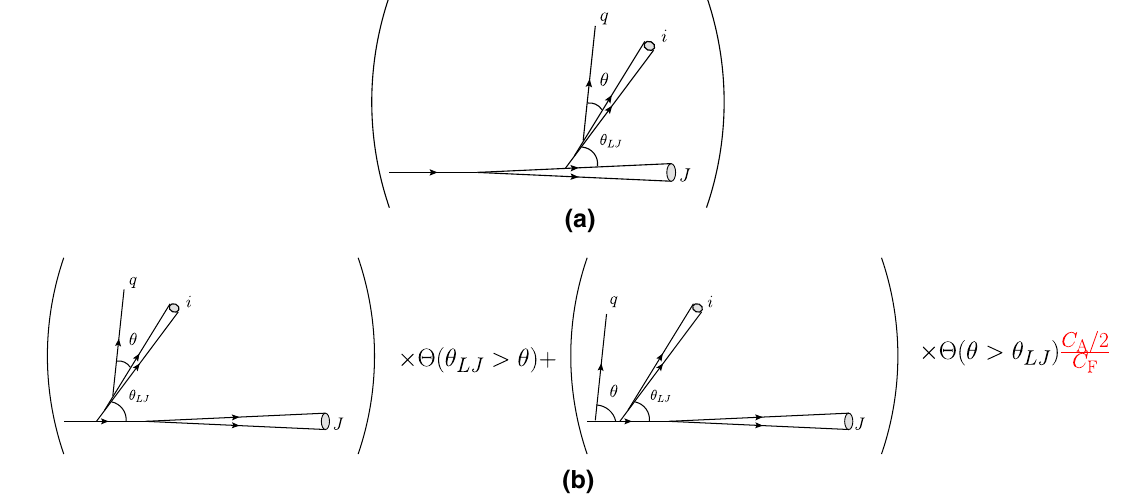
Fig. 7 The generalisation of Figs. 5 and 6 to an arbitrary fixed order. Cones i and J represent a unspecified number of parton branchings, each at angles smaller than θ LJ , which is the largest angle in q ’s sub- branch. As before, diagram a is generated by our dipole shower and